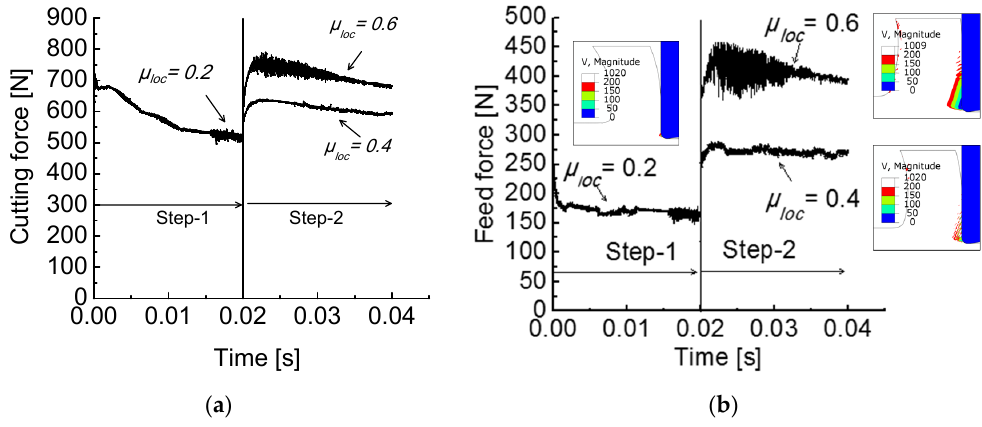
Figure 13. Effect of an abrupt change of COF on ( a ) the cutting force and ( b ) the feed force.